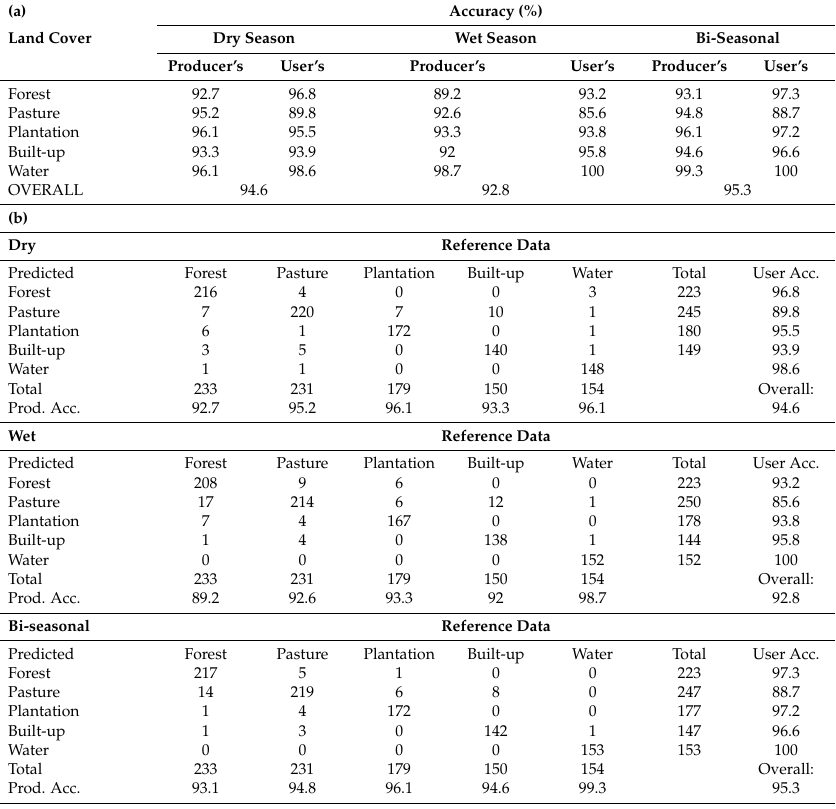
Table 2. Overall producer’s and user’s accuracies ( a ) and confusion matrices ( b ) for the three Random Forest (RF)